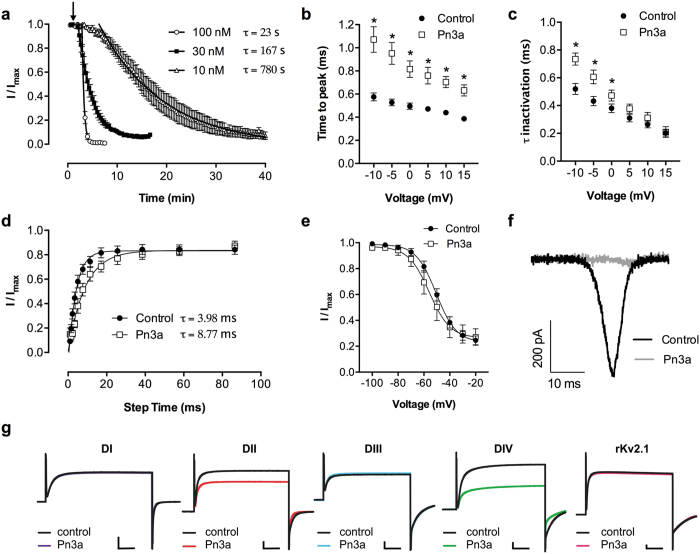
Additional effects of μ-TRTX-Pn3a on the electrophysiological parameters of hNaV1.7.(a) Time course of peak current reduction upon application of (arrow) 100 nM, 30 nM or 10 nM Pn3a at NaV1.7. Onset of block was measured with repetitive pulses to –20 mV every 20 s. Data are fitted with single-exponential functions and the time constant of block (τ) is indicated for each concentration. (b) Voltage-dependence of time-to-peak as a measure of activation kinetics at NaV1.7. Pn3a (100 nM) delayed time to peak between −20 mV and 15 mV. (c) Voltage-dependence of fast inactivation time constants at NaV1.7. Pn3a (100 nM) slowed the inactivation rate between −10 mV and 0 mV. (d) Rate of recovery from inactivation at NaV1.7. Pn3a (100 nM) slowed the rate of recovery from inactivation. Data are fitted with single-exponential functions and the time constant of recovery (τ) is indicated. (e) Steady-state slow inactivation at NaV1.7. Pn3a (100 nM) had no significant effect on the voltage-dependence of steady-state slow inactivation. Data are presented as mean ± SEM, with n = 4–6 cells per data point. Statistical significance was determined using two-way ANOVA, *P < 0.05 compared to control. (f) Representative ramp current elicited by a 50 ms depolarization from −100 to +20 mV at a rate of 2.4 mV/ms at NaV1.7. Pn3a (100 nM) inhibited ramp currents. (g) Potassium currents before (black) and in the presence of Pn3a (coloured) elicited by depolarisations to 70 mV in hNav1.7/rKv2.1 chimeras. Pn3a (300 nM) inhibited potassium currents in the DII hNaV1.7/KV2.1 and DIV hNaV1.7/KV2.1 chimeras. Scale bars: 50 ms (abscissa), 2 μA (DI, DII, DIV, KV2.1) and 1 μA (DIII) (ordinate axis).